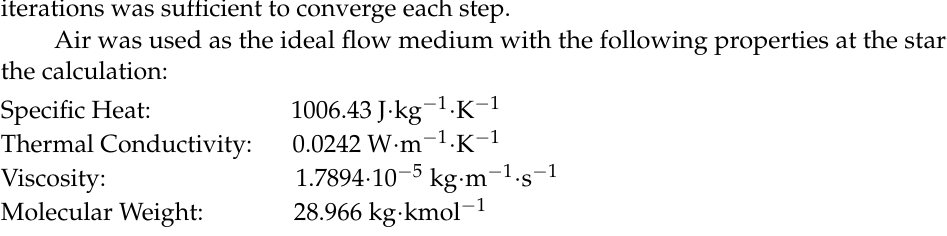
Figure 10. Boundary conditions on the 2D model of the experimental chamber.